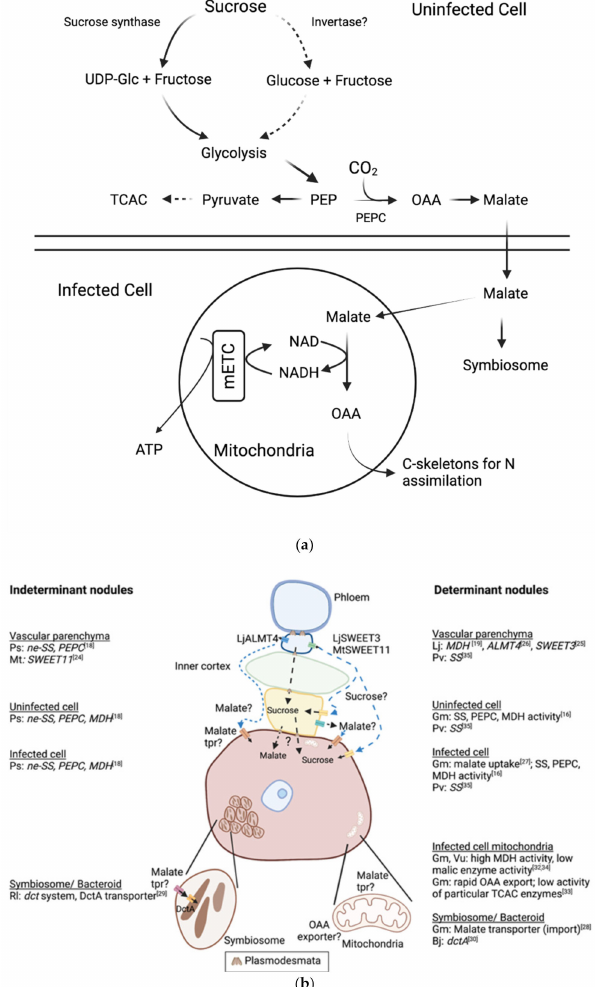
Figure 2. Nodule carbon metabolism. ( a ) The metabolism of sucrose to produce malate is likely to be in uninfected cells but may also occur in infected cells. In infected cells malate is transported to the symbiosome to support nitrogen fixation by bacteroids or to mitochondria, where it is used to generate ATP and the carbon skeletons required for nitrogen assimilation. Arrows with dashed lines indicate reactions that may occur but are unlikely to be significant in production of